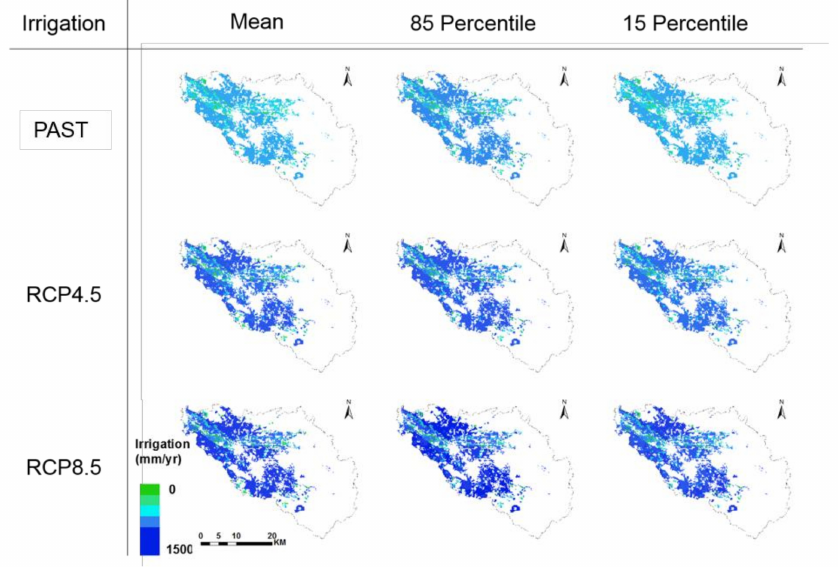
Figure 8. The annual amount of allocated irrigation water under 3 different scenario groups (spatial maps show the mean, 85th, and 15 percent range for each scenario group).